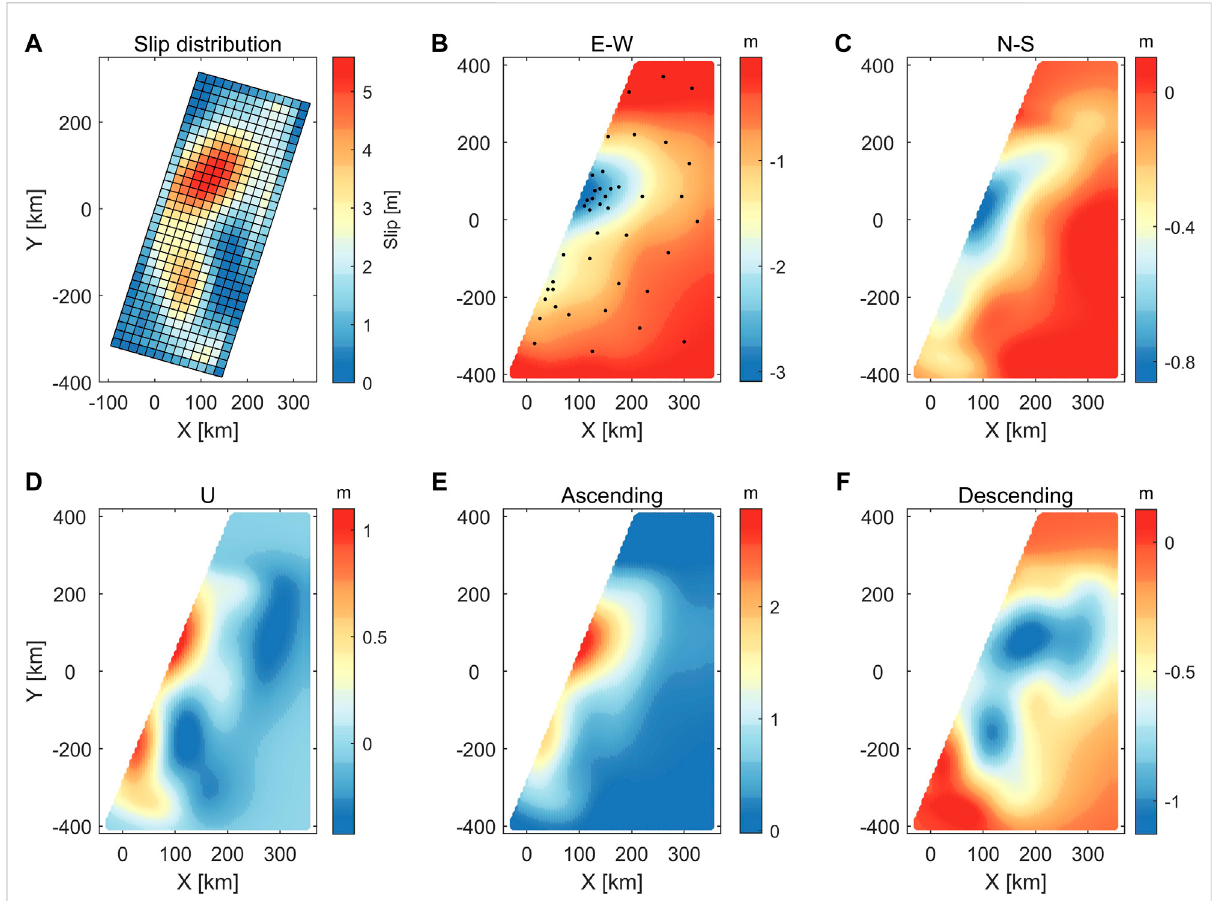
The simulated data used in the simulation experiments. (A) The slip distribution. (B – D) The simulated three-dimensional displacement fi eld according to the elastic half-space dislocation theory. (E,F) The simulated ascending and descending InSAR